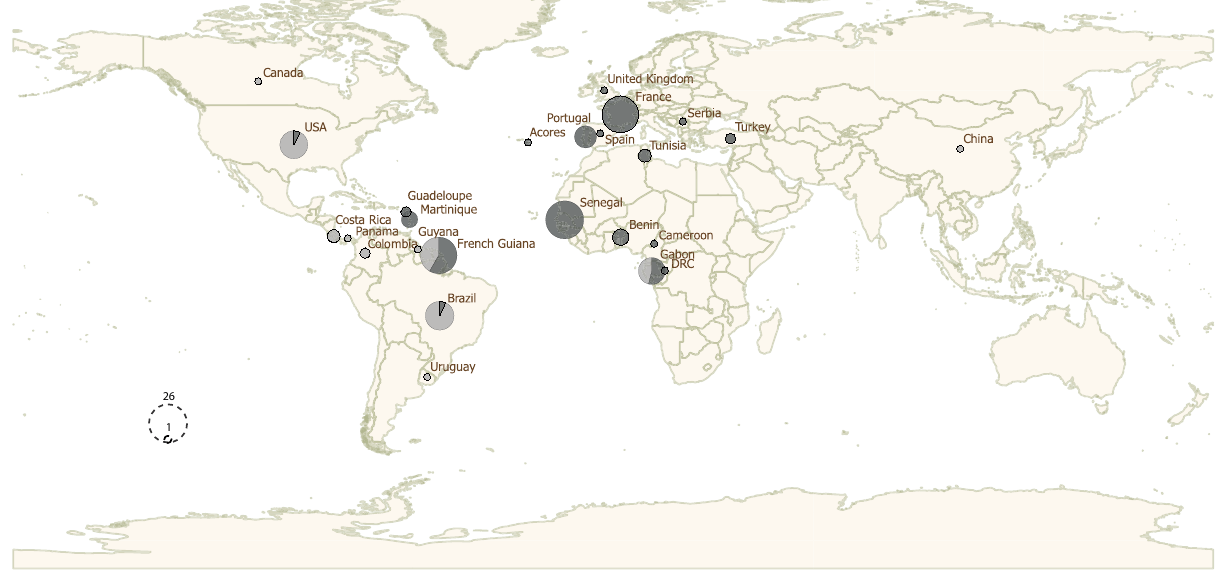
availableontheEuropeanNucleotideArchive(https://www.ebi.ac.uk/ena/browser/ home) — are represented in light grey. DRC is an abbreviation of Democratic Republic of